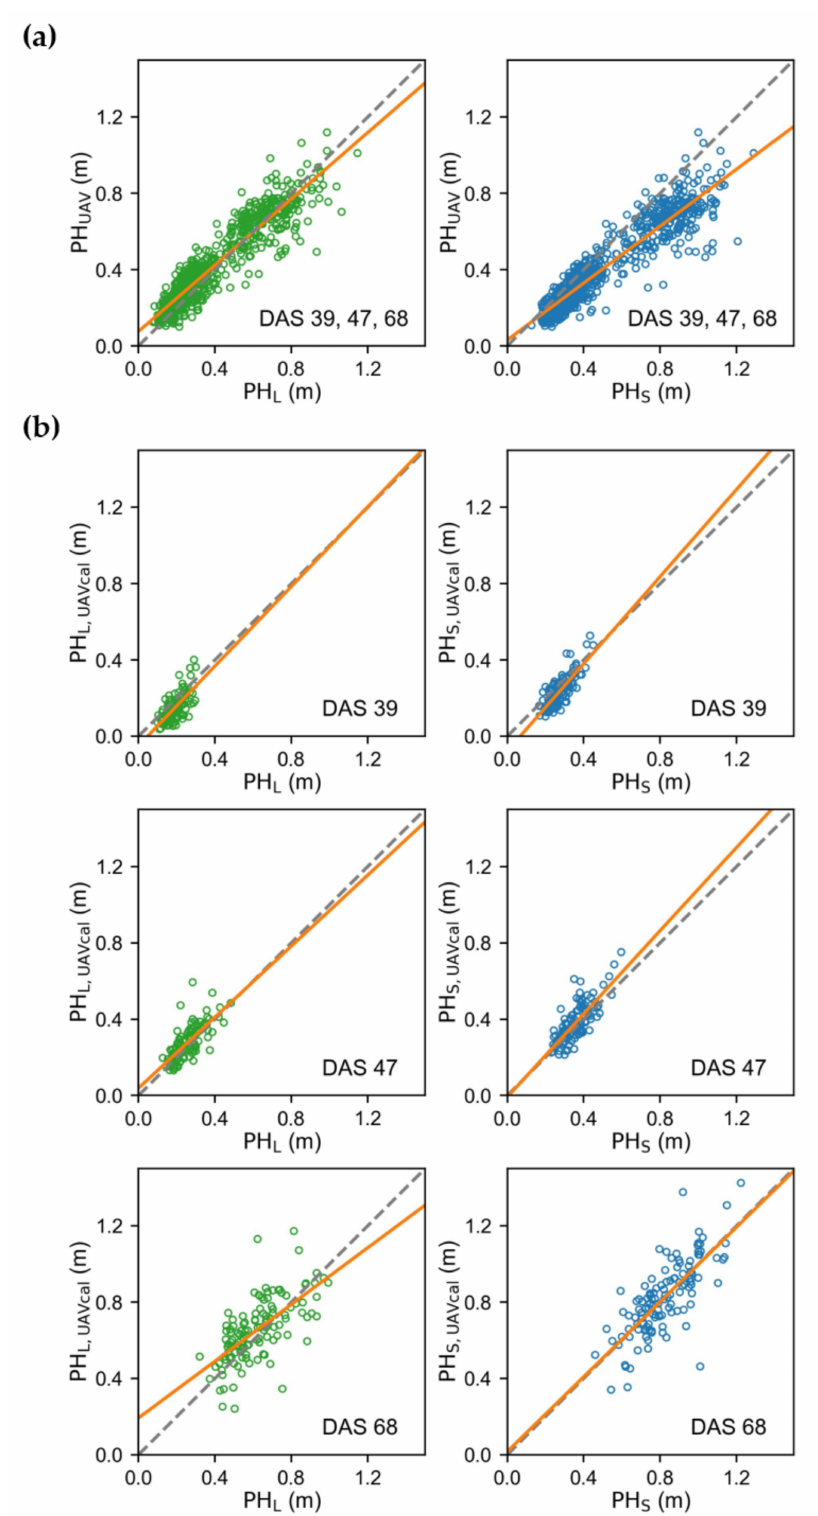
Figure 7. Calibration of UAV-based plant height estimation (PH UAV ) based on highest leaf (PH L ) and highest straightened leaf method (PH S ). The linear regression lines are shown in orange. ( a ) Data set for calibration of three dates combined. ( b ) Validation of calibrated data for predicting the plant height of highest leaf (PH L, UAVcal ) and the plant height of the highest straightened leaf (PH S, UAVcal ) based on UAV measurements. The regression equations are specified in Table 3; DAS: days after